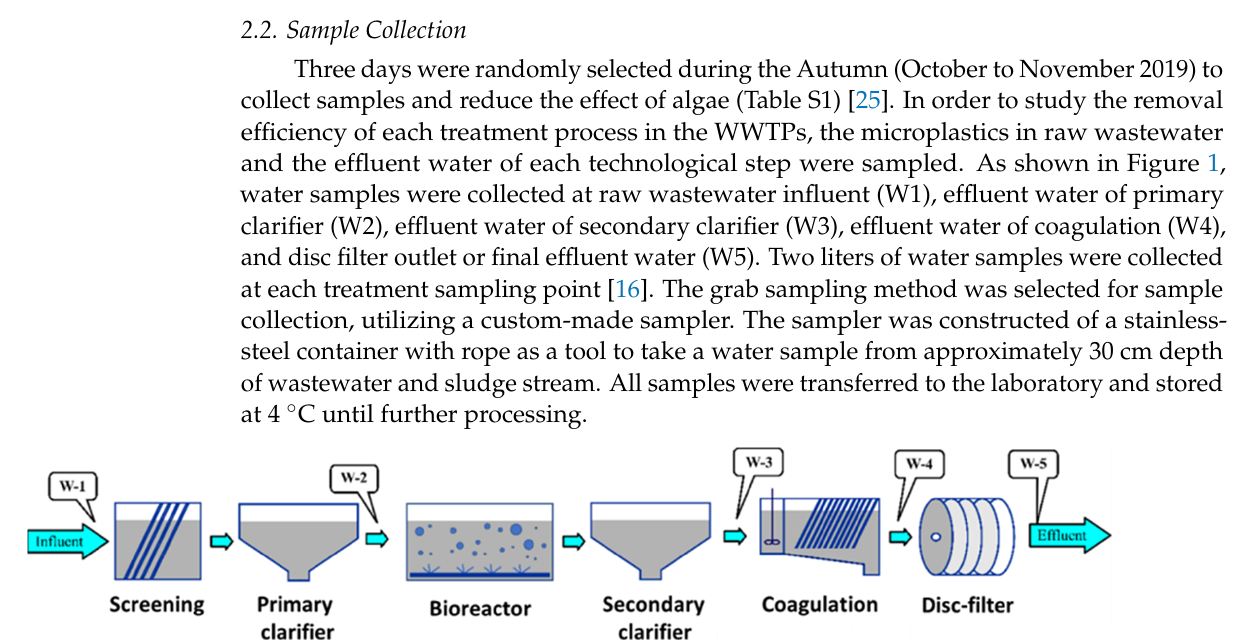
Table 1. Characteristics of WWTPs.